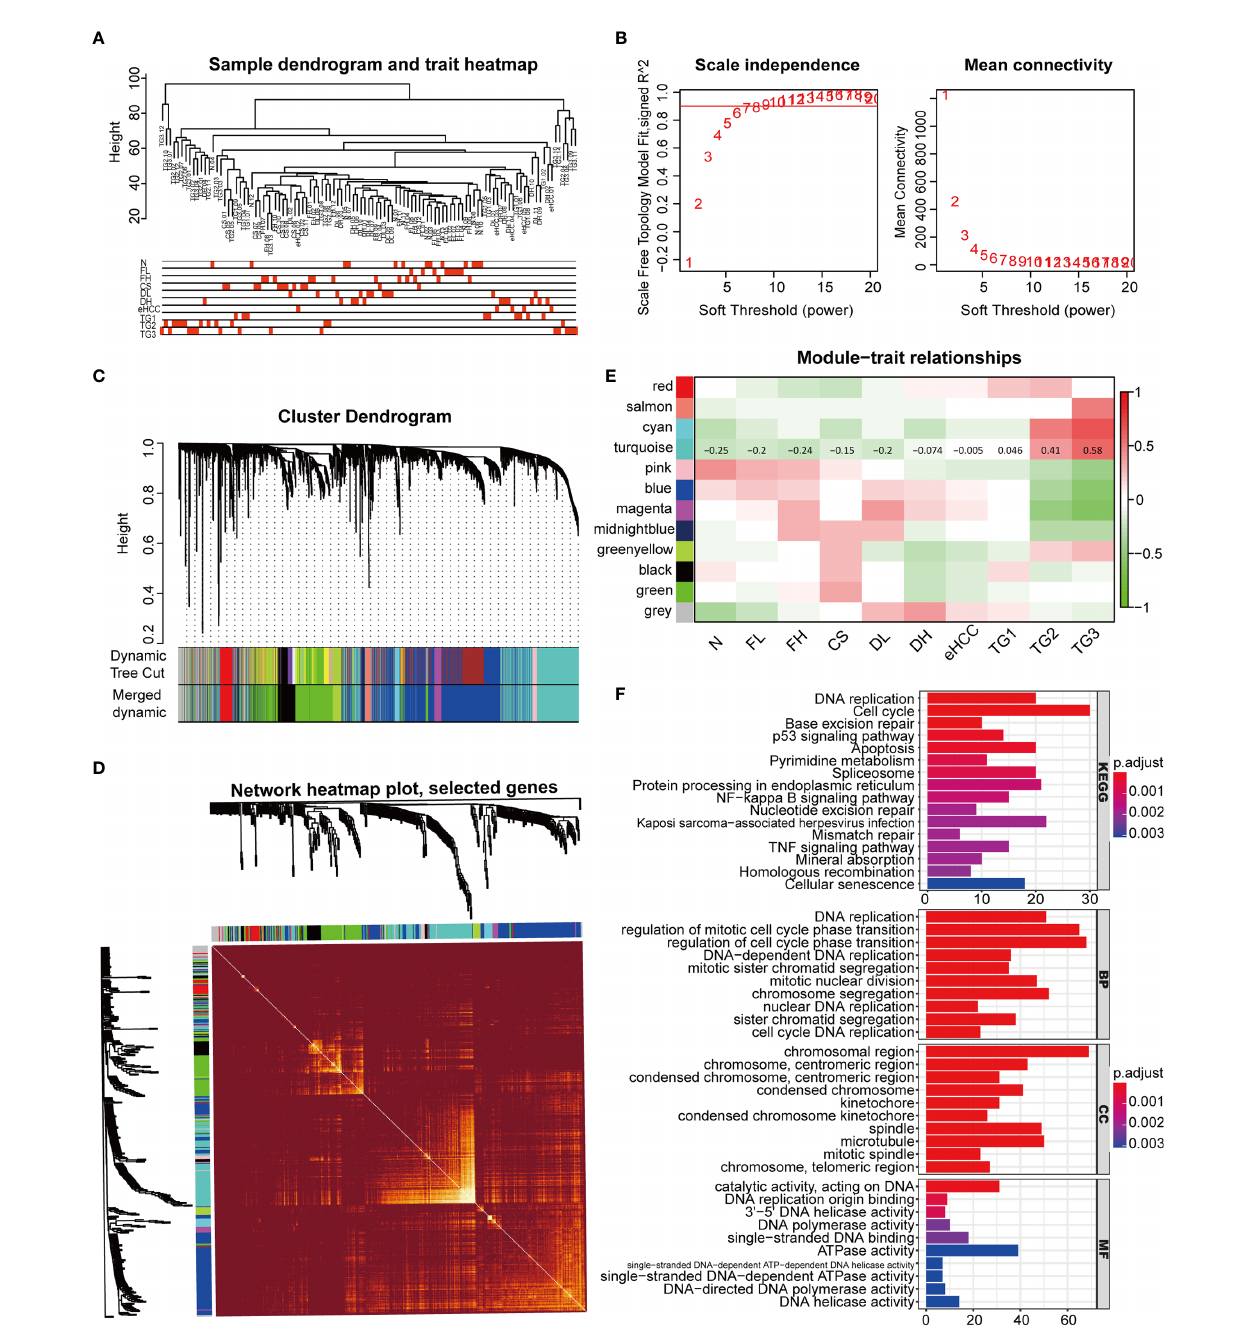
FIGURE 6 | Weighted gene co-expression networkanalysis(WGCNA)construction andidenti fi cation of the modulecontaining celldivision cycle associated 2 (CDCA2). (A) The WGCNA with group information was constructedthrough the RNA level of107 samples in GSE89377, includingnormal liver (N),chronic hepatitiswith low gradeand high grade(FL and FH), cirrhosis (CS),dysplastic nodules with low gradeand high grade(DL and DH),early-stage HCC (eHCC),and G1, G2, and G3 gradeHCC (TG1, TG2, andTG3). (B) Analysisofscale-free fi t index and the mean connectivity for varioussoft-thresholding powers. Testing the scale-freetopology when b = 9. (C) Hierarchical clustered expression mapsof different genes based on topological overlap,where modules were branches of cluster trees. (D) Heat map of gene topologicaloverlap matrix (TOM) overlap visualization with bright ordark colorsrepresenting higher orlower overlap, respectively. (E) In the correlation plot between modulegenes andclinical groups, each row correspondsto a module, columns represent clinical groups, red represents positive correlation,and green represents negative correlation.The correlation coef fi cients of the turquoise modulewere labeled in the fi gure. (F) Gene enrichment analysisofGene Ontology(GO) andKyoto Encyclopedia of Genes and Genomes (KEGG) signaling pathway was completed byR